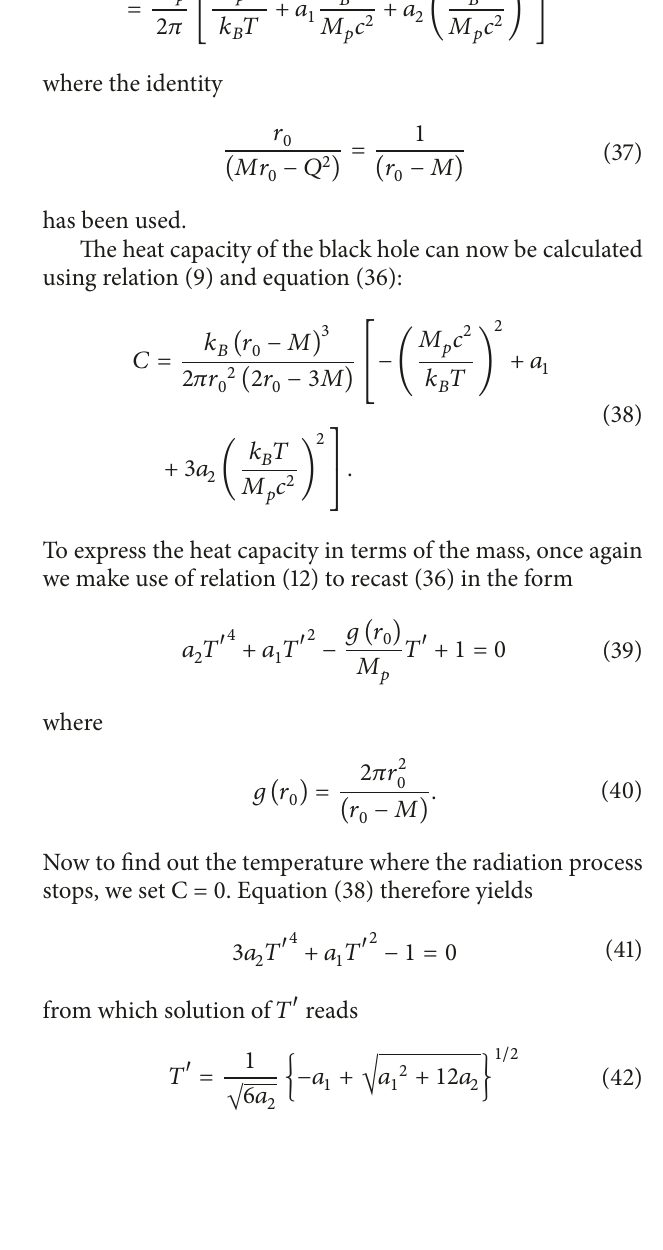
Figure 2: The mass of the black hole versus time. The mass is in units of Planck mass and the time is in units of characteristic time. Here thin line (lower curve) represents GUP case (considering both 𝑎 𝑎 2 and 1 ), the dashed line (middle curve) represents GUP case (considering only 𝑎 1 ), and thick line (upper curve) represents the standard case.